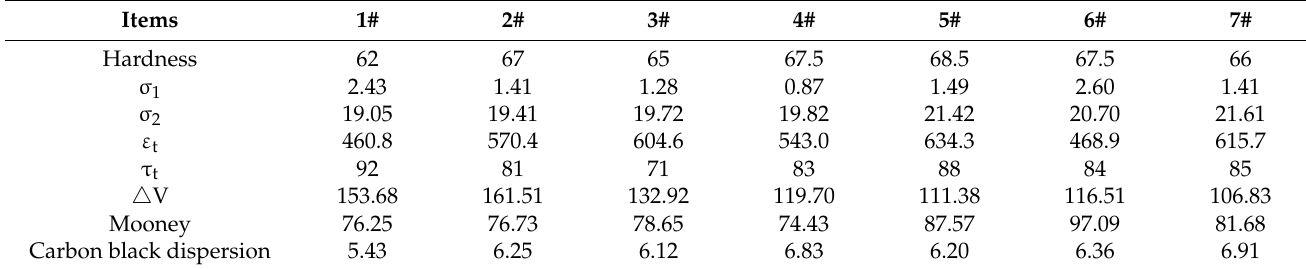
Table 4. Results data of experiments for vulcanizate properties without extrusion.